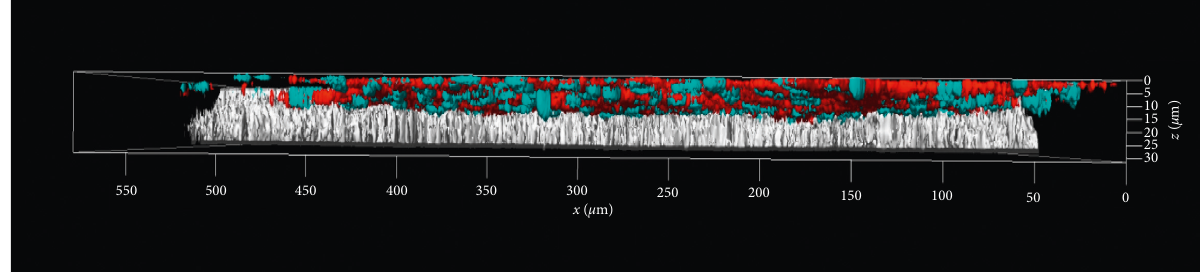
Figure 9: 3D reconstruction of HAC-EDTA by confocal laser scanning microscopy. After 14 days, the cell monolayer (blue/red colored) was homogenously adhered over the HAC-EDTA surface